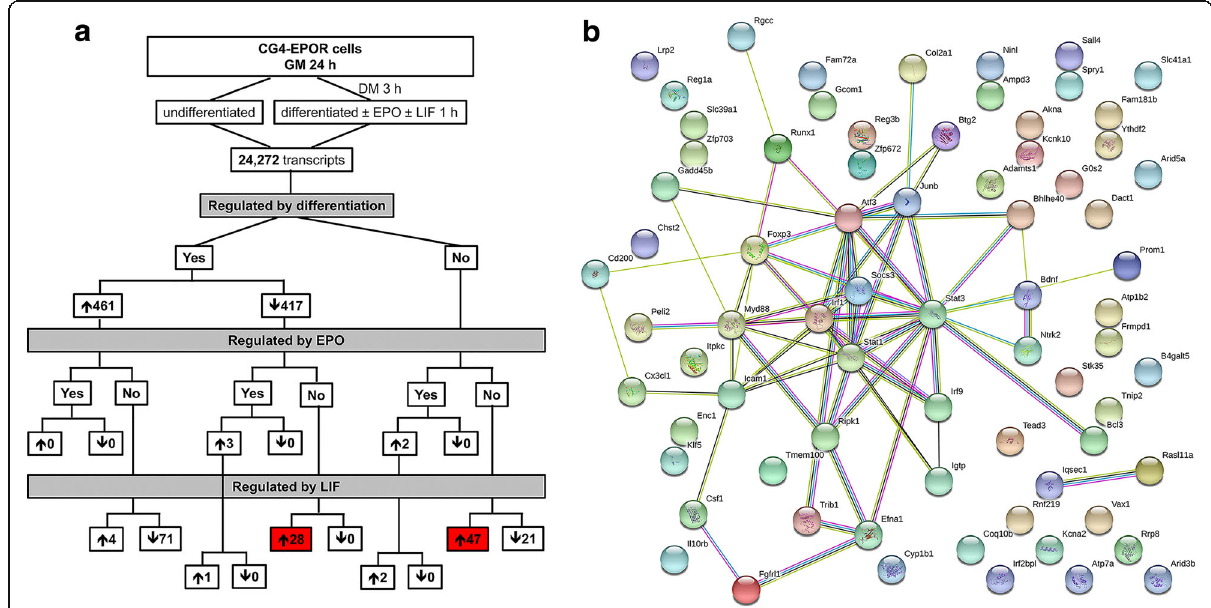
Fig. 2 Genes regulated by LIF at 1 h. Cells cultured for 1 day in GM were switched to DM; after 3 h EPO with or without LIF was added and cells were incubated for further 1 h. a Flow chart. Genes regulated by differentiation were selected by comparing differentiating (4 h culture with DM) vs undifferentiated cells; genes regulated by EPO by comparing EPO-treated (1 h) vs untreated differentiating cells; genes regulated by LIF by comparing EPO + LIF-treated (1 h) vs EPO-treated cells. Cut-off for selection was FC of 1.5 (log 2 FC of 0.58) and BH adj. P value < 0.05. The number of upregulated or downregulated genes resulting from filtering is indicated. Negative regulators induced by LIF and unchanged by differentiation or EPO (47) or decreased by differentiation (28) are highlighted in red. b Gene-gene interaction network of the putative negative regulators increased by LIF at 1 h. All the genes increased by LIF and either unchanged by differentiation or EPO (47 genes, Fig. 2a) or decreased by differentiation alone (28 genes, Fig. 2a) were analysed with the STRING software and the gene-gene interaction network was visualised. None of the genes increased by LIF were decreased by EPO at this time point. Different line colours represent types of evidence for association: green line, neighbourhood evidence; red line, fusion evidence; purple line, experimental evidence; light blue line, database evidence; black line, co- expression evidence; blue line, co-occurrence evidence; yellow line, text mining evidence. The full list of all the 75 genes and the relative expression changes induced by LIF and by differentiation are reported in Additional file